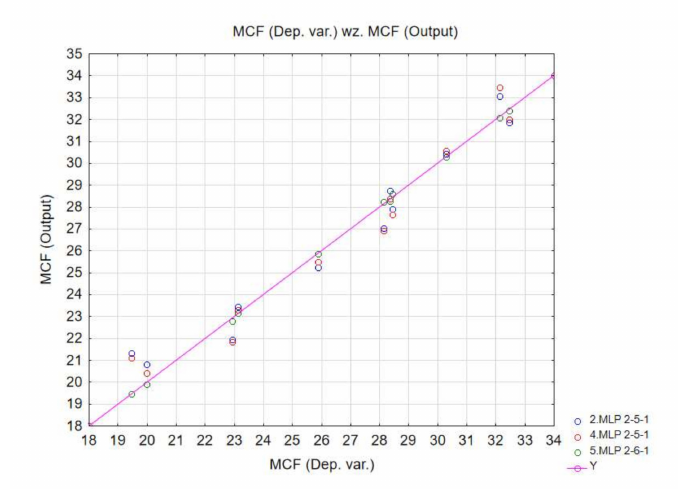
Figure 16. MCF neural network training quality.